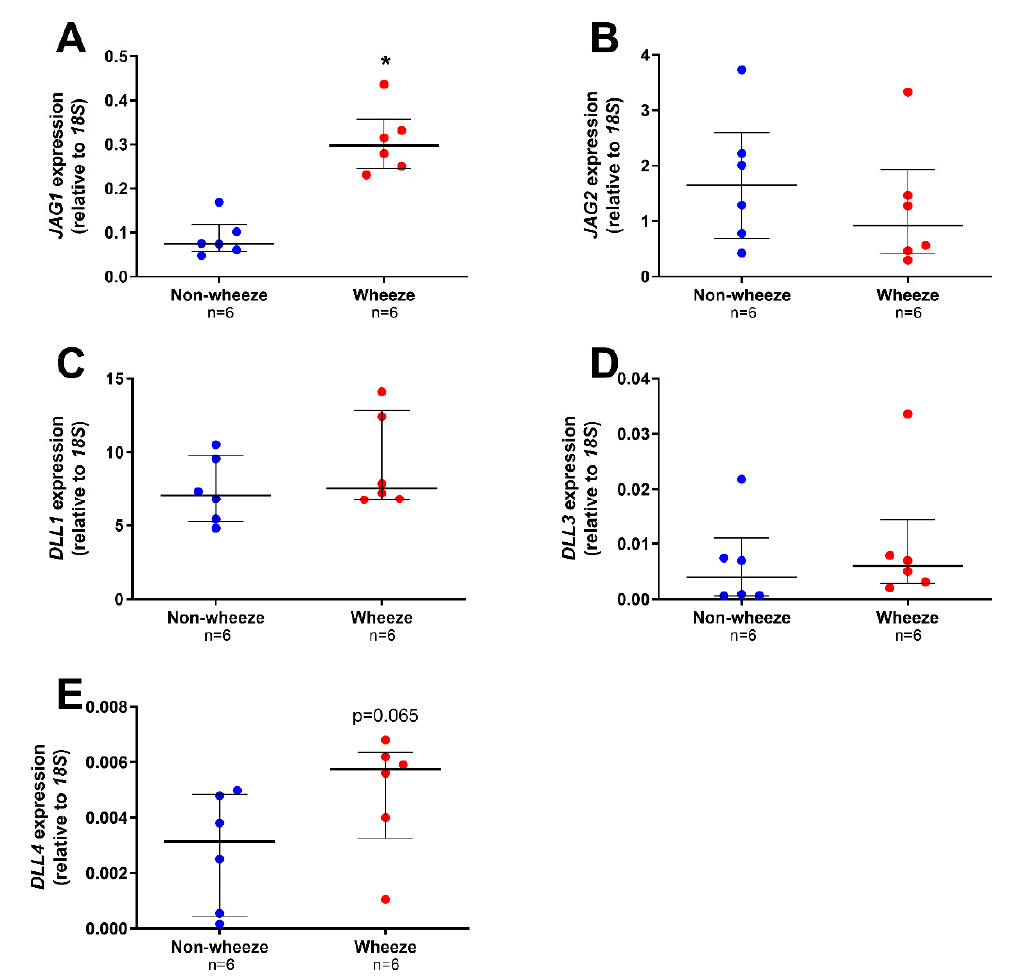
Figure 3. Notch ligands gene expression profiles in ex vivo pAEC from children with and without wheeze. Relative expression of Notch ligands; JAG1–2 ( A , B ) and DLL1-4 ( C , E ) were measured in ex vivo pAEC from children with and without wheeze ( n = 6) by real-time qPCR. ( A ) mRNA expression of JAG1 was significantly increased in pAEC from children with wheeze compared to their non-wheeze counterparts. ( B ) JAG2 mRNA expression was not significantly different between pAEC from children with and without wheeze. ( C , E ) DLL1 was the most abundantly expressed Notch ligand in ex vivo pAEC from a paediatric cohort. However, no significant differences were observed between pAEC from children with and without wheeze in mRNA expression of DLL1 ( C ), DLL3 ( D ) and DLL4 ( E ), although the genes were expressed at different magnitudes. Each dot represents the mean of two replicates from a single ex vivo sample. Data are normalized to housekeeping gene, 18S and represented as median ± IQR. * Statistical significance relative to the non-wheeze cohort ( p < 0.050; Mann–Whitney U-test).